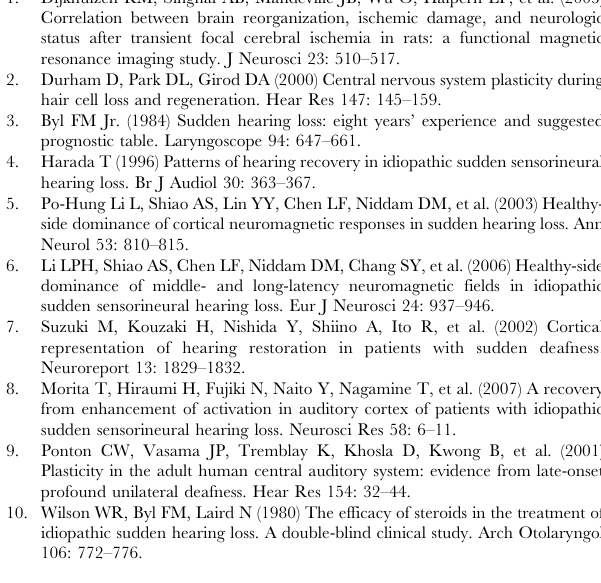
Table S1 Amplitude and latency of N100m dipole